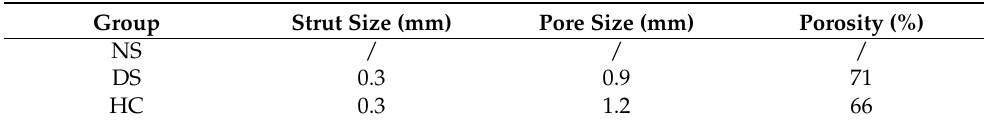
Table 3. Parameters of different surface